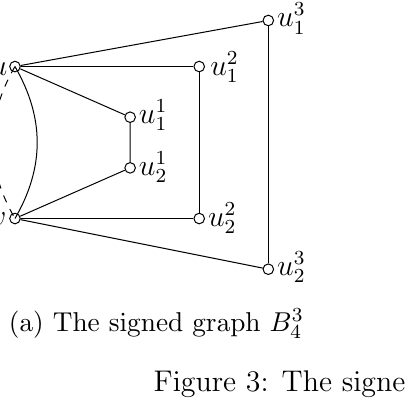
Figure 3: The signed graphs B 3